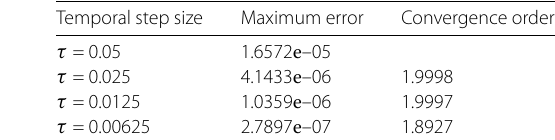
Table 10 The convergence order for R-CFDS4 at h = 0.0025